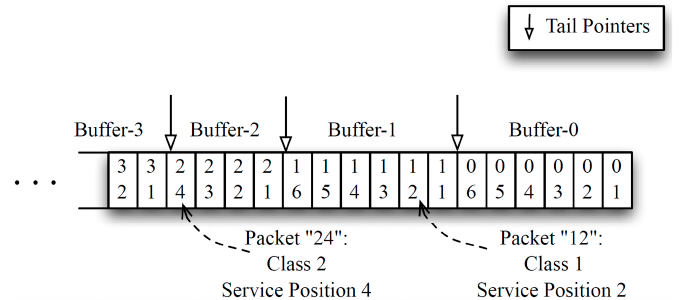
Figure 3. Logical concatenation of the buffers.